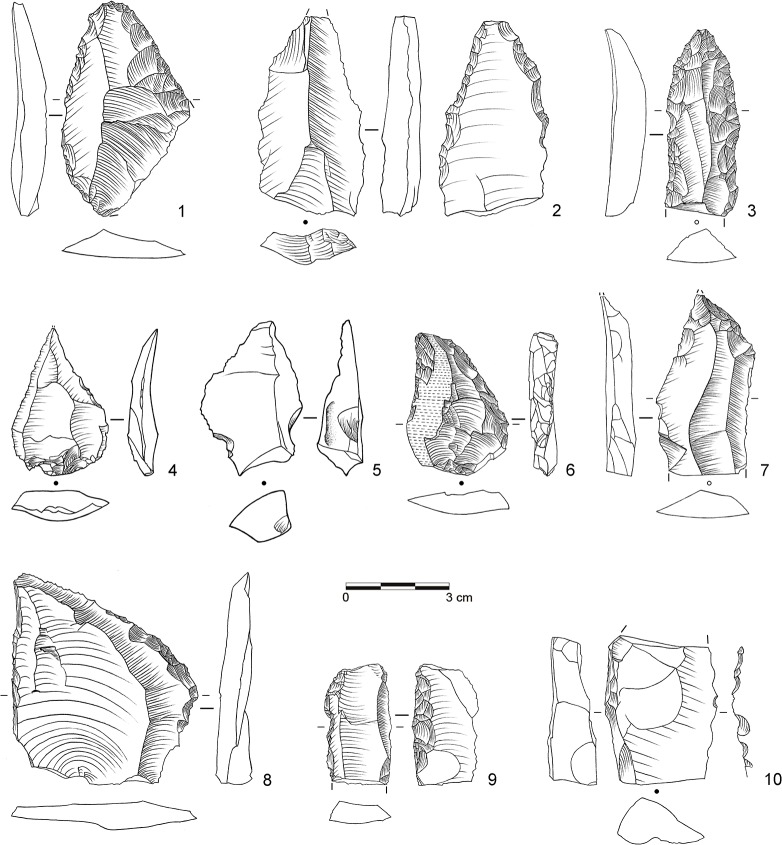
Selection of tools from assemblage SU.1–2: Unifacial point, Tongati (both dolerite, C3-999, C3-991); 3: Unifacial point, Ndwedwe (dolerite, D3-1036); 4: Unifacial point (dolerite, E3-1092); 5: Unifacial point, notched (dolerite, E2-922); 6–7: Unifacial point, ACT (both dolerite, C3-1032, C2-1012.18); 8: Transverse scraper, NBT (dolerite, C3-996); 9: Lateral retouch (dolerite, D3-1078); 10: Denticulate, NBT (dolerite, C3-979.1). (Drawings by L. Brandt and M. Lajmiri)